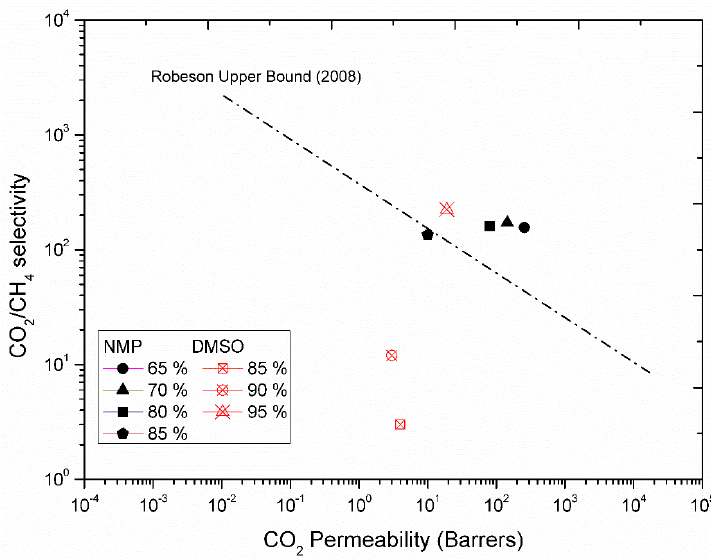
Figure 9. Effect of bore solvent and bore composition on gas permeation properties.